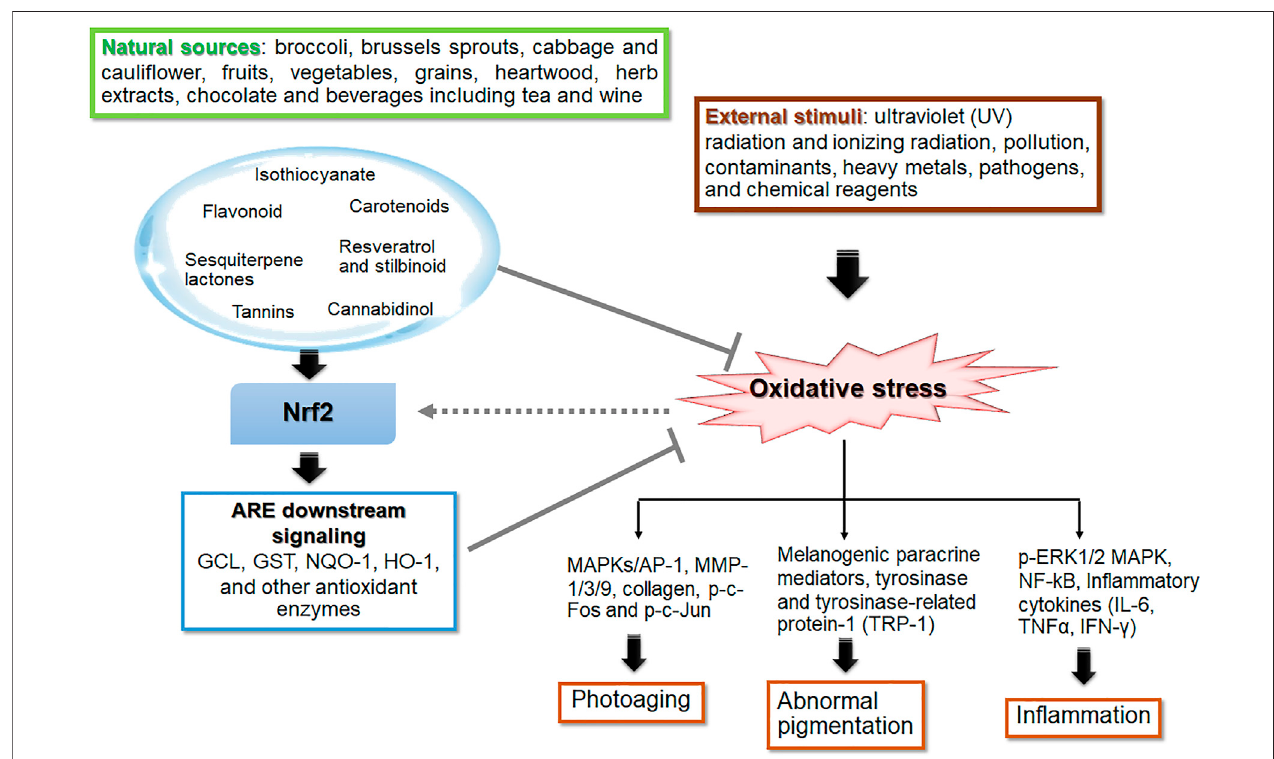
FIGURE 2 | The role of phytochemicals in skin photoprotection via regulation of Nrf2 signaling. Phytochemicals are naturally occurring compounds in botanical products which exert biological activities providing medical and nutritional bene fi t. Oxidative stress, an imbalance in the redox state of the cell, is the result of cellular responsetovariousstimuliincludingUVandionizingradiation,pollution,contaminants,heavymetal,pathogens, andchemicalreagents.Mostofthenaturalantioxidants are derived from plant materials such as fruits, vegetables, grains, legumes, botanical drugs, spices and plant-based beverages (including tea, coffee, wine and cocoa). The bioactive phytochemicals, e.g., isothiocyanates (in broccoli, brussels sprouts, cabbage and cauli fl ower), fl avonoids, carotenoids, resveratrol and stilbinoid, exhibit a wide range of photoprotective effects, including anti-photoaging, anti-in fl ammation, and anti-melanogenesis. These protective effects involve activation of nuclear factor erythroid 2-related factor 2 related to the antioxidant response element (Nrf2-ARE) signaling pathway that regulates expression of its downstream target genes including glutamate cysteine ligase (GCL), glutathione S-transferase (GST), NAD(P)H quinone oxidoreductase-1 (NQO-1), heme oxygenase-1 (HO-1) and other antioxidant genes, to cope with various stressors including UVR. The thick arrows and bar-headed linesmean activation and inhibition of the pathway, respectively. The dash arrow means modulation of Nrf2 signaling by ROS levels.